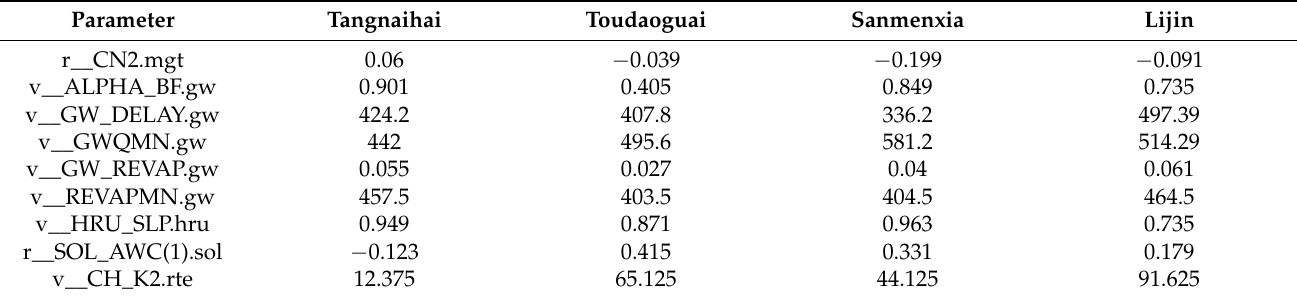
Table 3. The optimal parameter values in Soil & Water Assessment Tool (SWAT) model of the four hydrological stations.